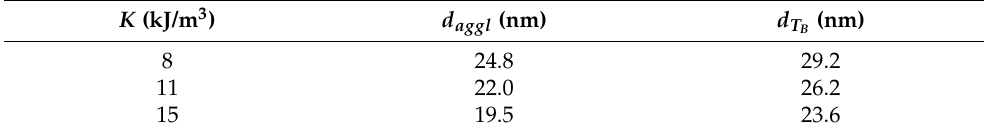
Table 1. Agglomeration size thresholds obtained through the relaxation times approach ( d aggl ) and through the ZFC/FC one ( d T ), at room temperature for the three anisotropy cases of Figure B